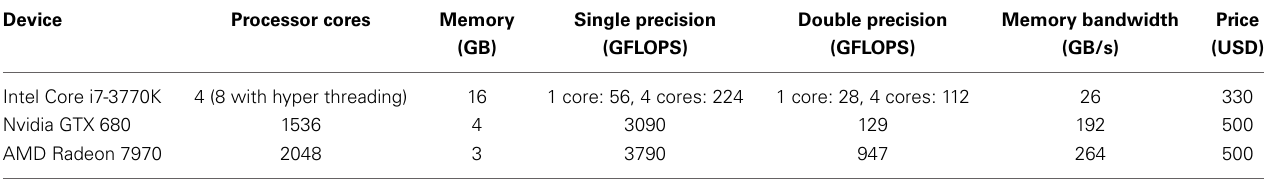
Table 1 | Hardware configuration and performance measures of the computer used for testing the different software packages.